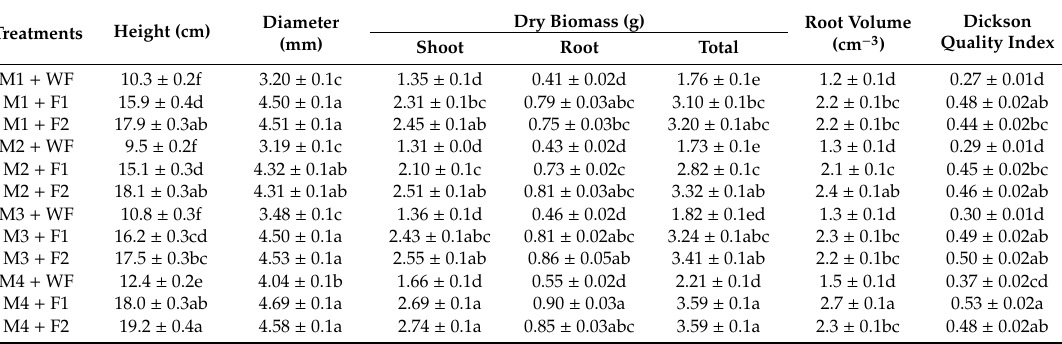
Table 3. Average values (mean ± standard error) for the morphological variables by treatments, in the growth of Pinus cembroides Zucc. after 14 months under nursery conditions. Dry Biomass (g) Root Volume Diameter Treatments Height (cm) (mm) (cm − 3